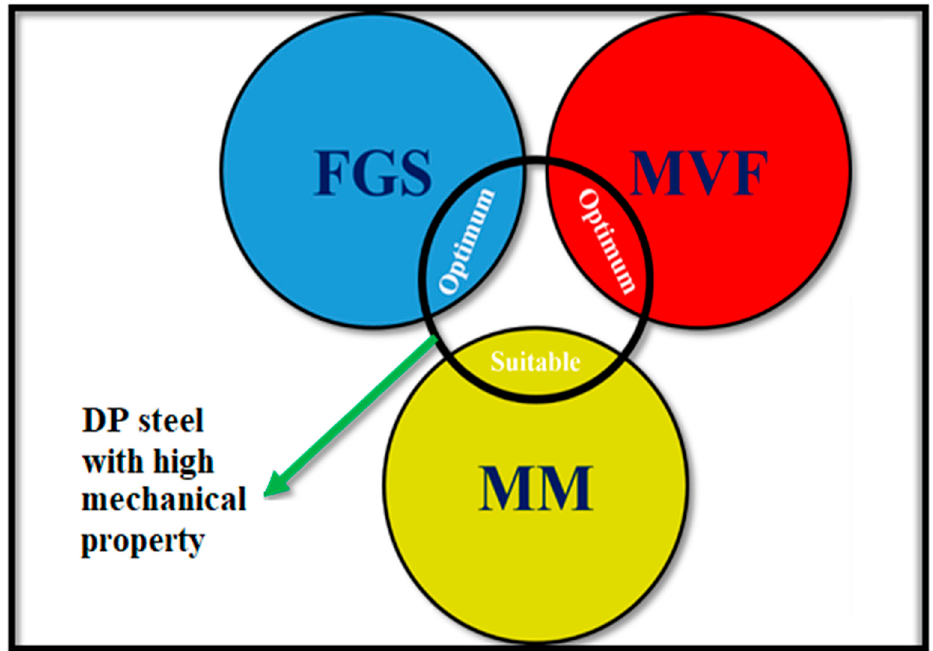
Figure 9. The role of FGS, MVF, and MM for achieving a DP steel with highest strength–ductility balance along with high mechanical properties. balance along with high mechanical